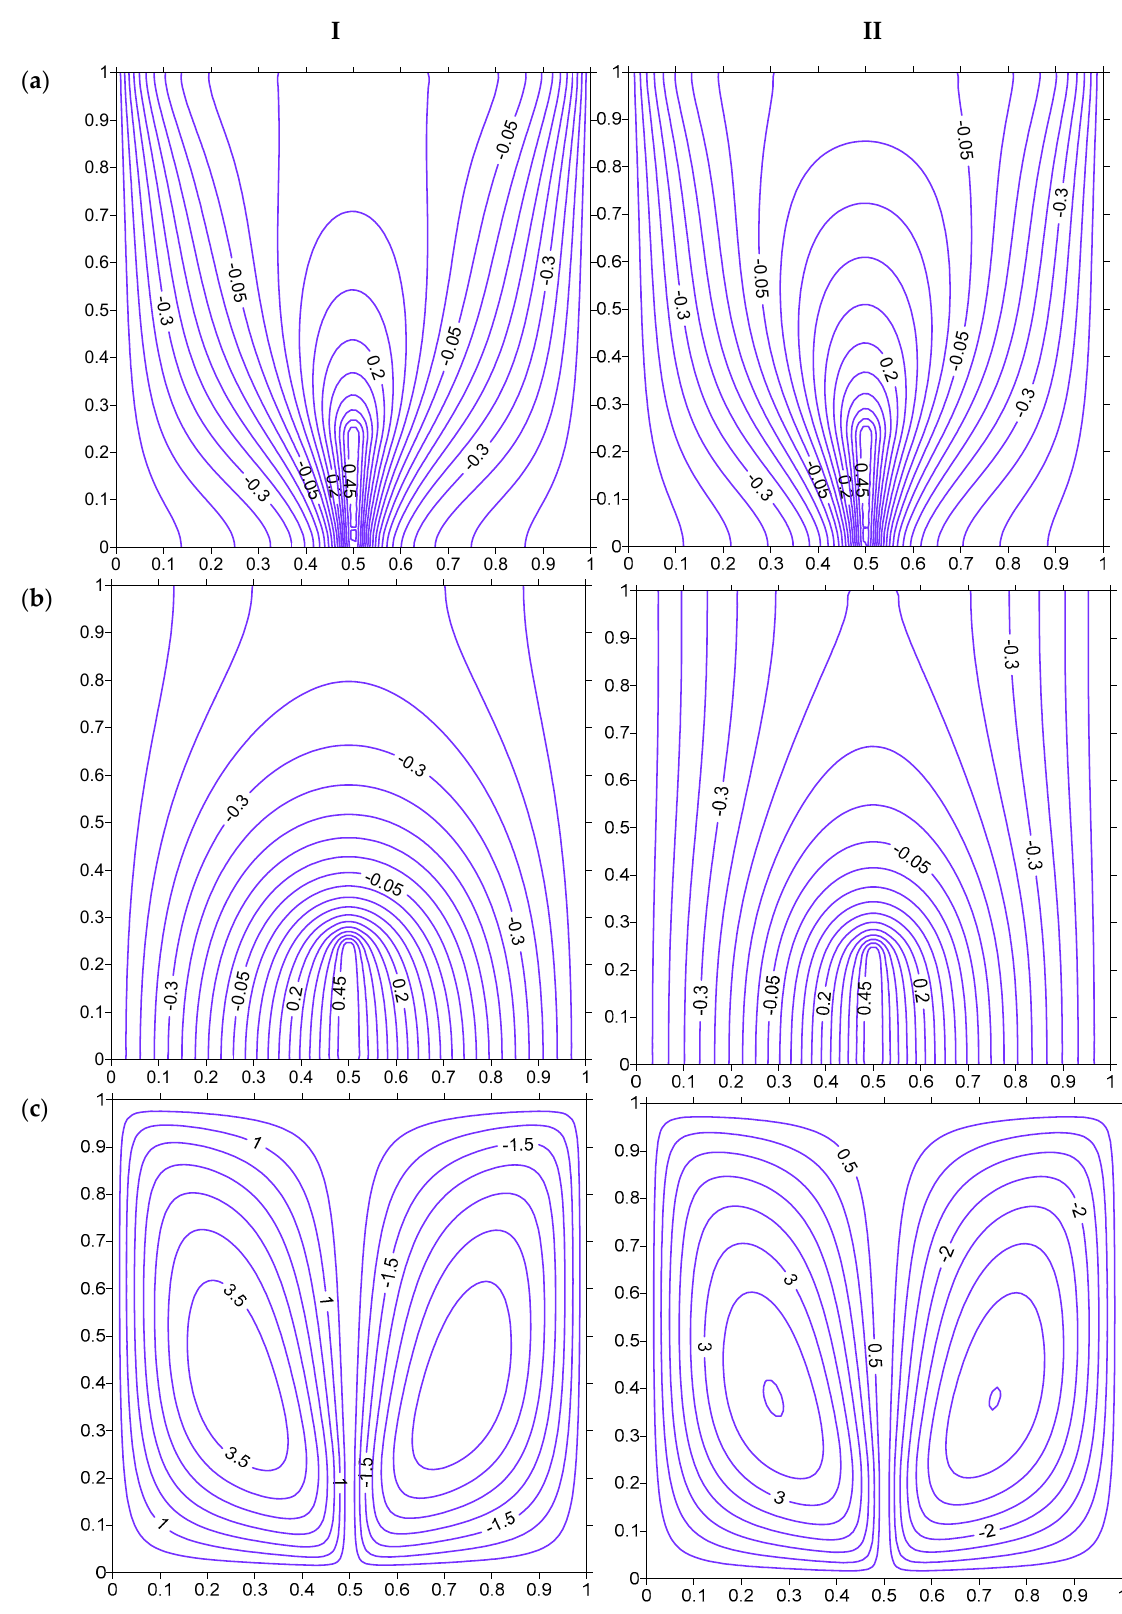
Figure 10. Isotherms (( a ) Fluid, ( b ) Solid), and streamlines ( c ), at Ra = 100, HH = 25%, Kr = 1, Rd = 0 for strip at x = 0.5. ( I ) H = 0.1. ( II ) H =